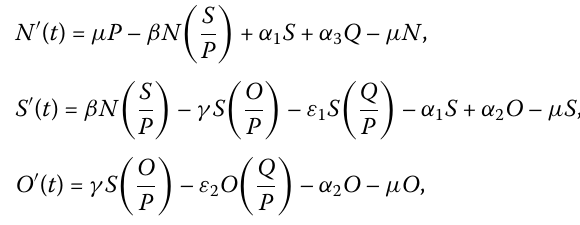
(ii) Parameters ε 1 , ε 2 . We explore how the levels of obesity are impacted by alterations to the peer pressure rate of quitter on overweight ( ε 1 ) and the pressure rate of quitter on obese ( ε 2 ). To begin, we set obesity at the highest level (from the previous case), that is, when β = 0.2 and γ = 0.1. The numerical simulations in Fig. 4 illustrate the time varia- tion of obesity in four cases: ε 1 = ε 2 = 0.01, ε 1 < ε 2 , ε 1 = ε 2 = 0.05, and ε 1 > ε 2 . From these simulations, we find that the level of obesity declines when ε 1 < ε 2 . Furthermore, obesity decreases to a lower level when ε 1 = ε 2 = 0.05. It appears as if the quitters’ peer pressure rates had a major impact in helping to control the fast food eating habits of obese individ-